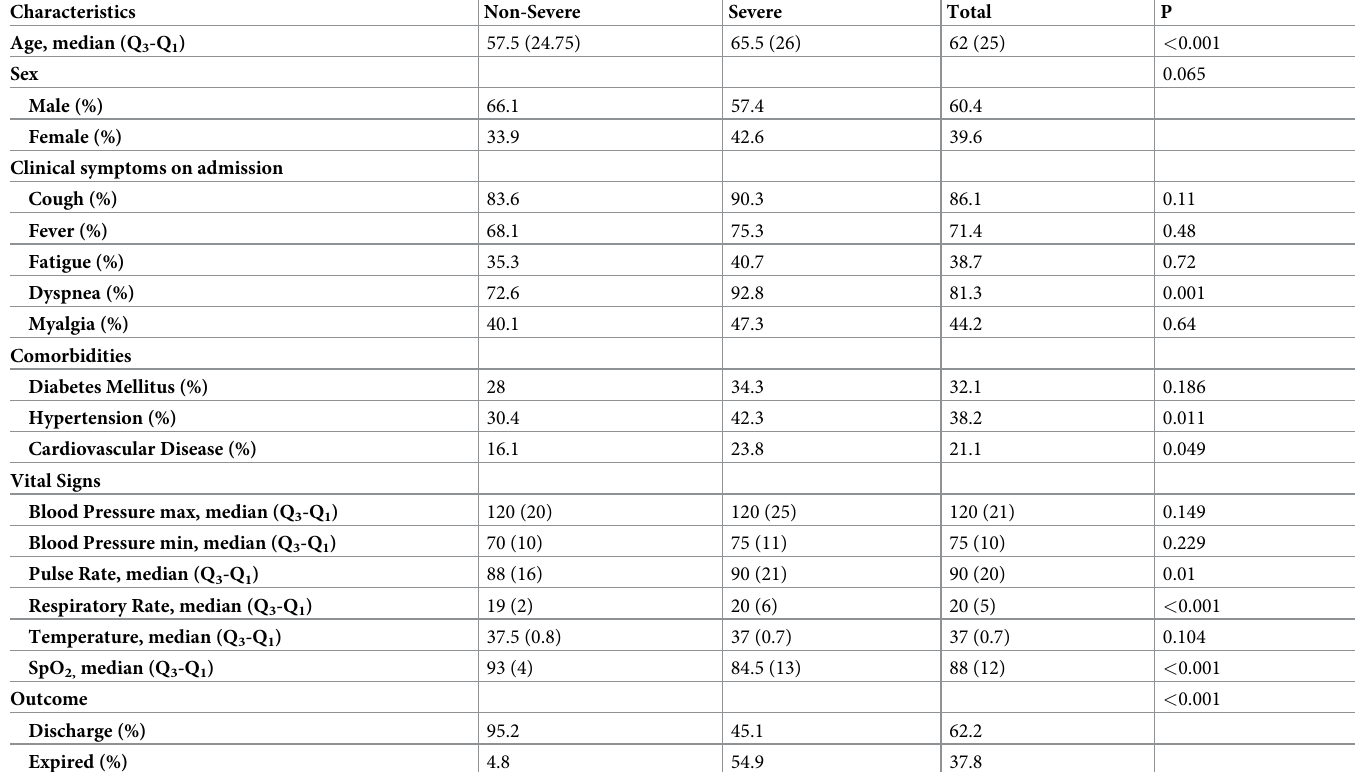
Table 2. Demographic, clinical features and mortality outcome of patients collected from medical records.